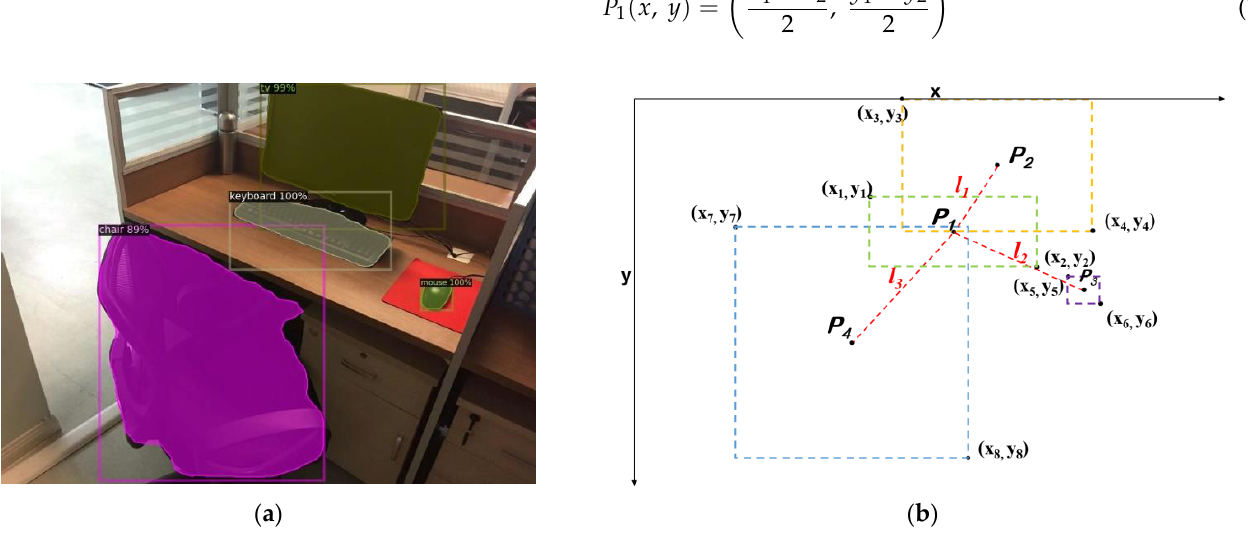
Figure 3. Using object detection to infer relevance: ( a ) An example of detection results of Mask R-CNN; ( b ) The position coordinates of different objects.